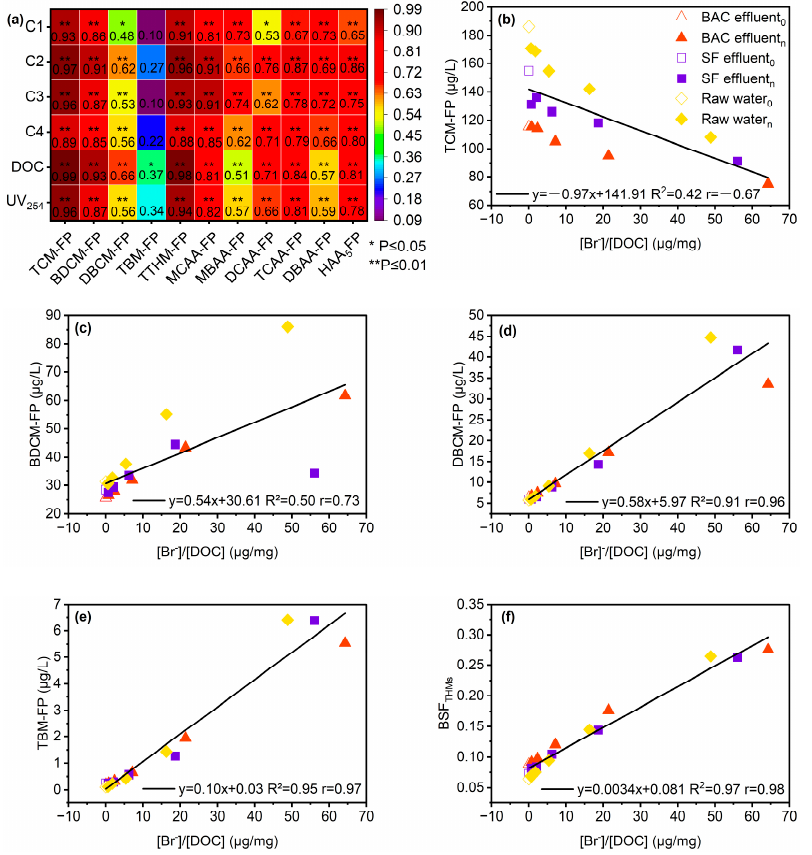
Figure 4. ( a ) Heatmap of Pearson correlation coefficients of DBPFP for different species versus water quality indicators characterizing NOMs; and plots of ( b ) TCM-FP, ( c ) BDCM-FP, ( d ) DBCM-FP, ( e ) TBM-FP, and ( f ) BSF THMs versus [Br − ]/[DOC] with linear regression lines. In panel ( a ),